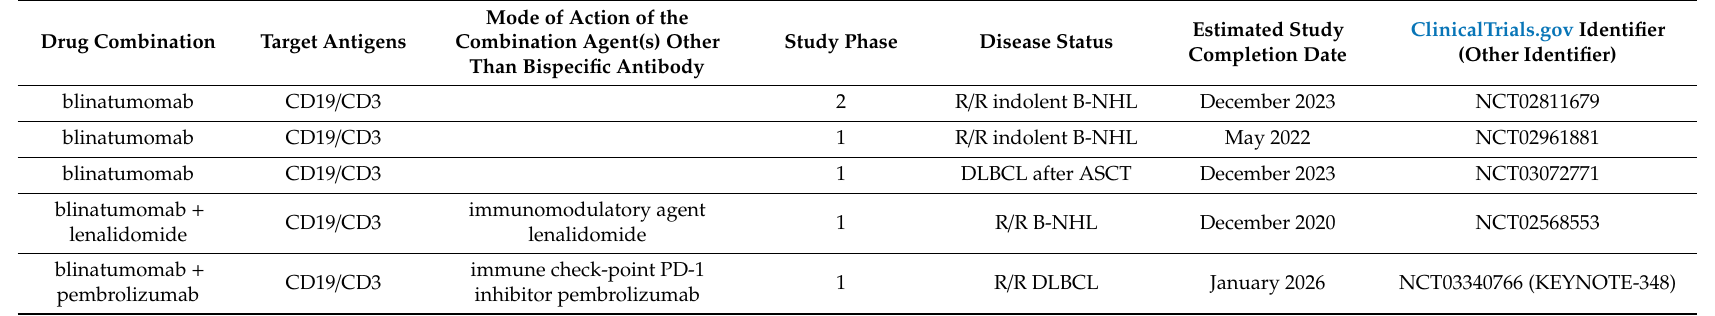
Table 1. Selected clinical trials that incorporate blinatumomab in experimental therapy of